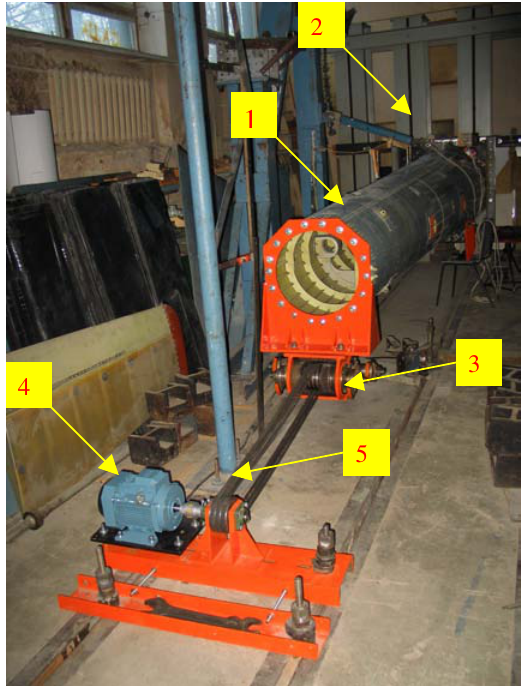
Fig 1. Stand of dynamic testing of an MI-8 helicopter tail beam (1–tail beam, 2–support, 3–mechanical vibrator, 4–motor, 5–V-belt